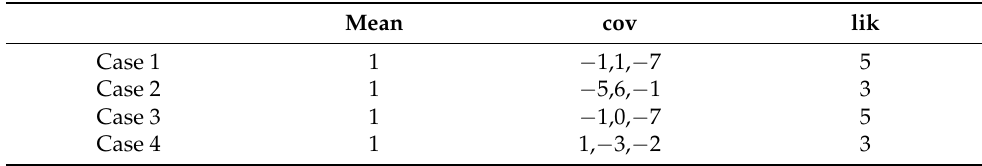
Table 8. Measures of models.